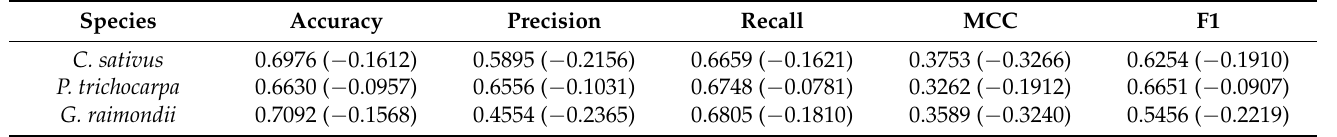
Table 11. Performance of CircPCBL on three independent test sets when training with rice only (the values in parentheses show the decrease in contrast to previous